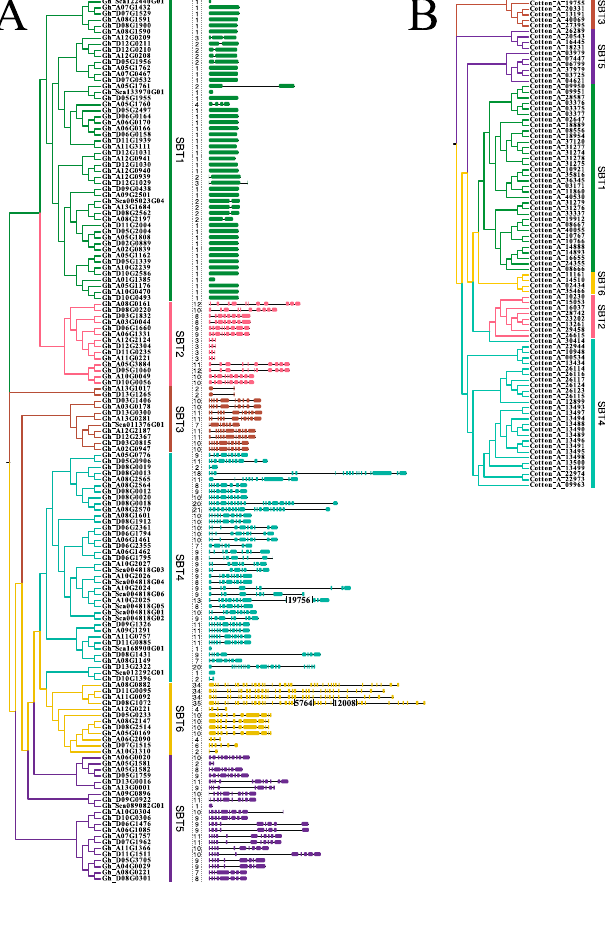
Figure 2. SBT gene structure of cotton. ( A ) SBT gene structure of Gossypium hirsutum . The phyloge- netic tree is built by FastTree. ( B ) Genetic structure of Gossypium arboretum . The phylogenetic tree is built by FastTree. ( C ) Isoform structure of Gossypium raimondii . Different gene models as a result of alternative splicing or alternative start codons are numbered consecutively as Gorai.0XXGXXXXXX.1, .2, etc. The evolution tree is built by FastTree. The squares are CDS, the horizontal lines are introns. Dark green, pink, brown, cyan, purple and dark yellow lines represent subfamilies from SBT1 to SBT6, respectively. The dotted line is exon number.